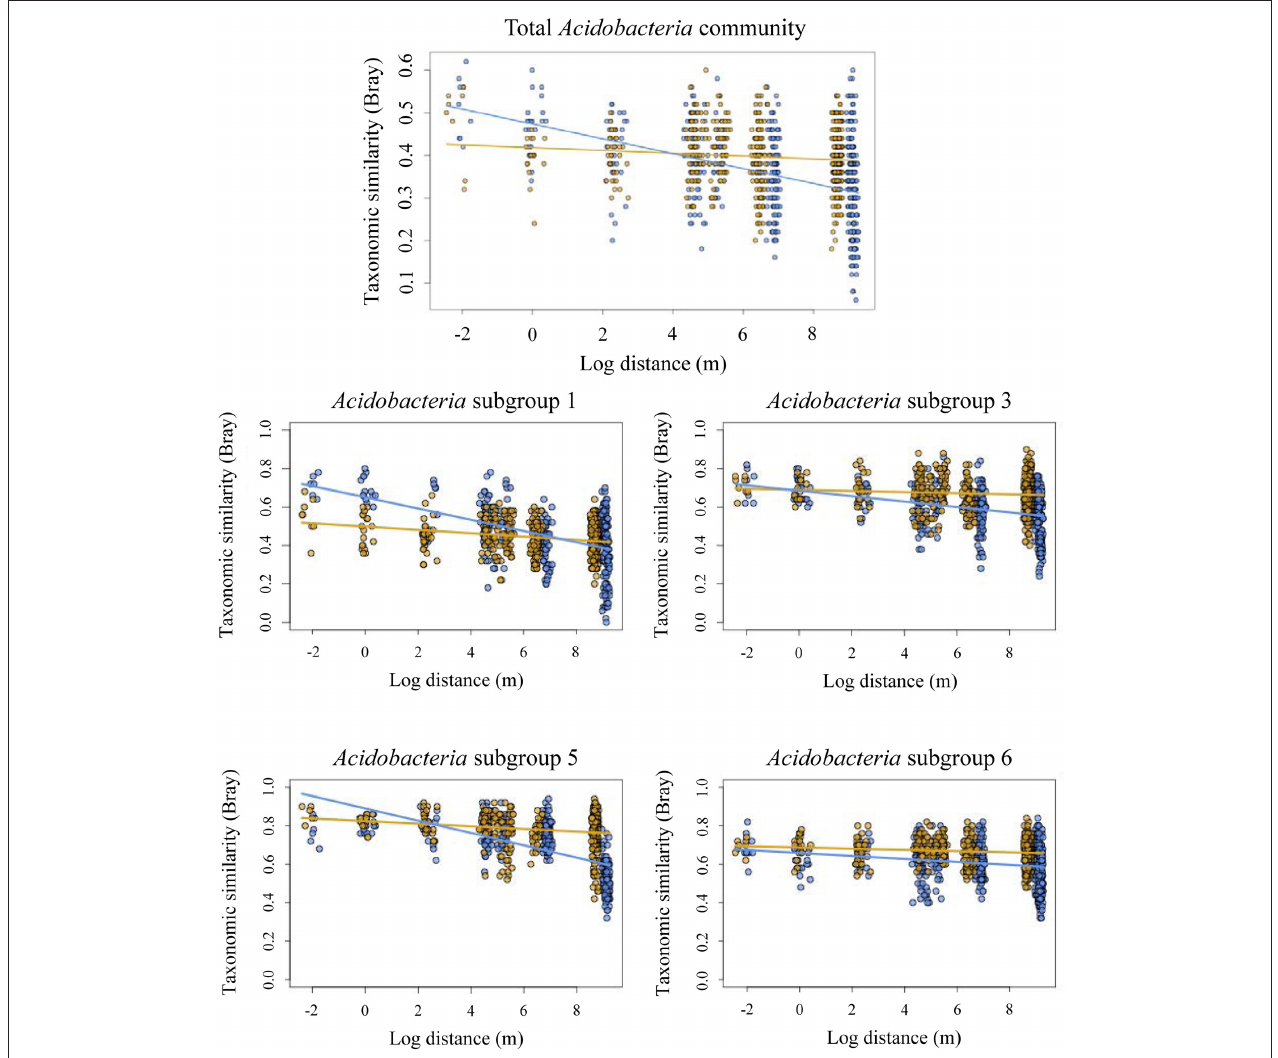
FIGURE 2 | Decay of taxonomic similarity (Bray–Curtis) with geographic distance in forest (blue) and pasture (yellow) for total acidobacterial community and Acidobacteria subgroups 1, 3, 5, and